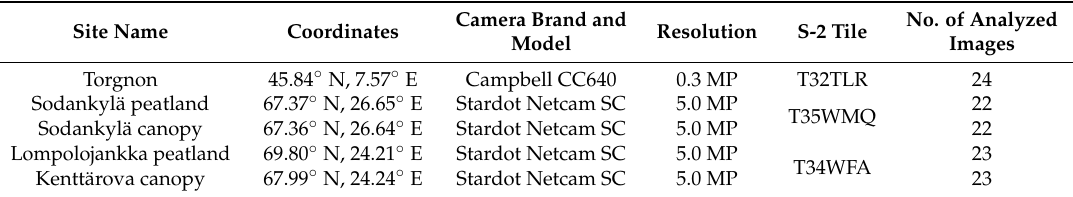
Table 5. Selected in-situ cameras in Finland and Italy.